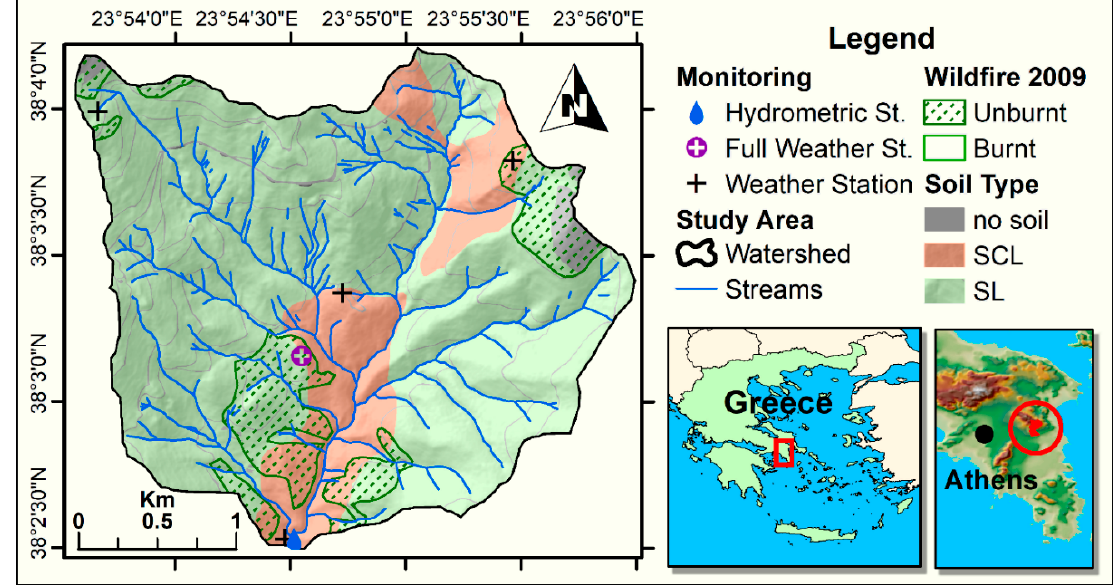
Figure 1. Map of the study area, where the topography, the soil, the land cover and the monitoring network are shown.